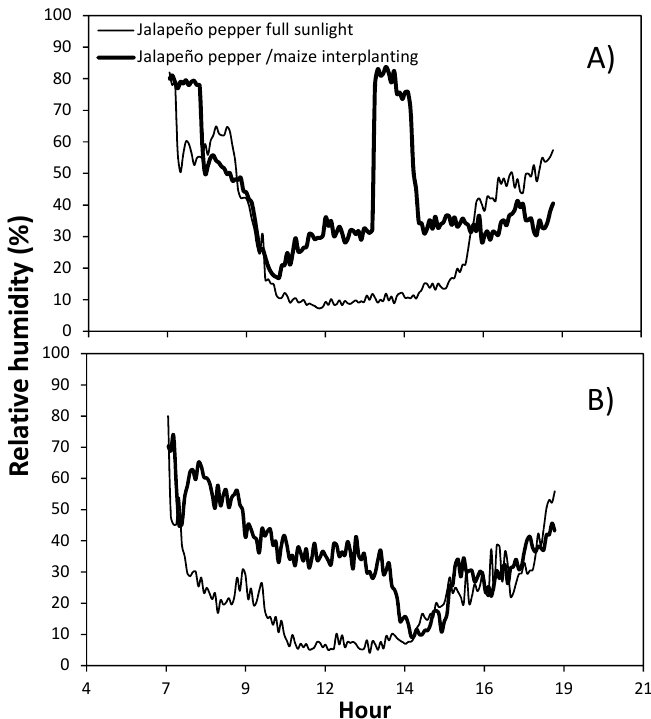
Figure 4. Relative humidity recorded at jalapeño pepper canopy level as affected by intercropping, on ( A ) 16 April and ( B ) 12 May 2016.